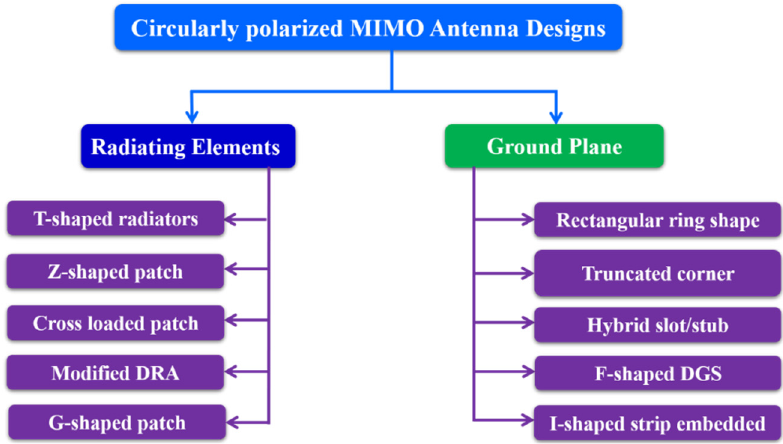
Figure 17. Circularly polarized MIMO antennas design approaches.